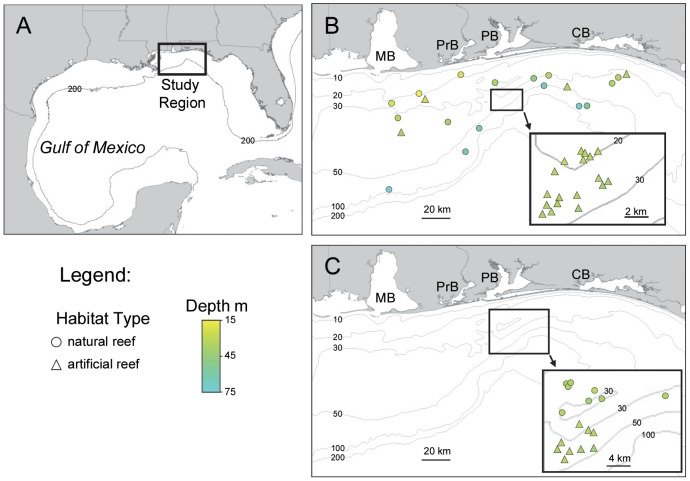
Location of study sites for lionfish density and diet sampling.A) Map of the Gulf of Mexico with study region indicated. B) Natural (circles) and artificial (triangles) reef sites sampled with a remotely operated vehicle in fall 2010–2013 to estimate invasive lionfish density; water bodies: MB  =  Mobile Bay, PrB  =  Perdido Bay, PB  =  Pensacola Bay, and CB  =  Choctawhatchee Bay. C) Natural (circles) and artificial (triangles) reef sites sampled by divers who speared lionfish for stomach content and muscle stable isotope analysis.